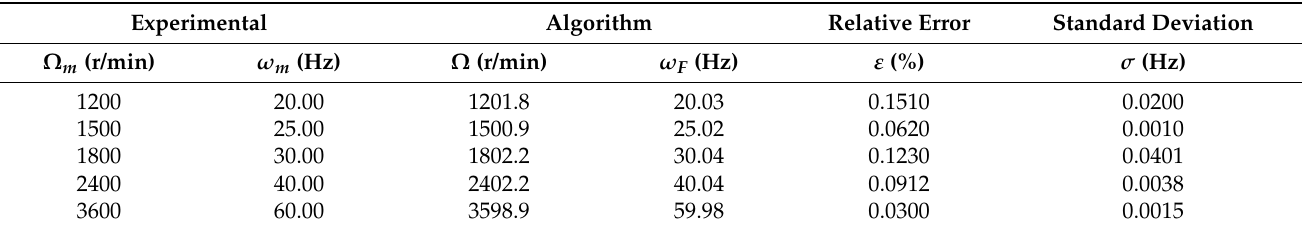
Table 8. No load coupled to the motor shaft: estimated speeds and frequencies, relative errors, and standard deviations for no-load tests with frequency converter. Experimental